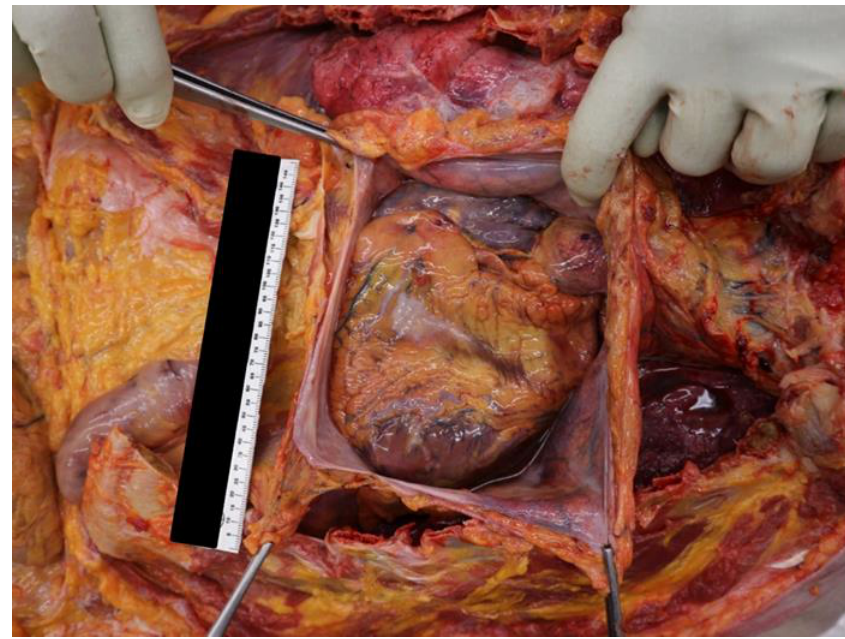
Figure 2. Macroscopical details of the heart and pericardium of the patient.